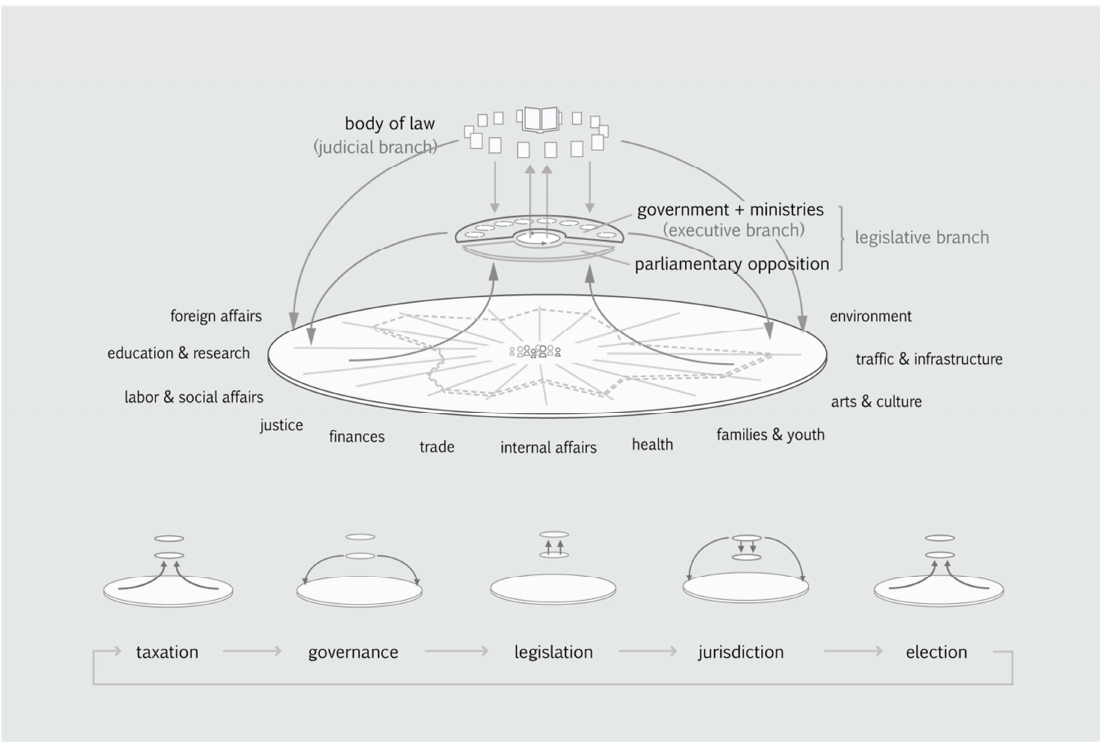
Figure 7: Political infographic, illustrating the political system of a democratic state based on the separation of powers. With all resources provided by the people (taxation), governments ( executive branch ) are managing ‘networks of networks’, provide problem solving solutions for matters of public concern (governance), develop laws (legislation) in conjunction with representative bodies ( legislative branch ), and are controlled by the judiciary , which also provides jurisdiction to the people, who in turn frequently evaluate the actors in all these institutions